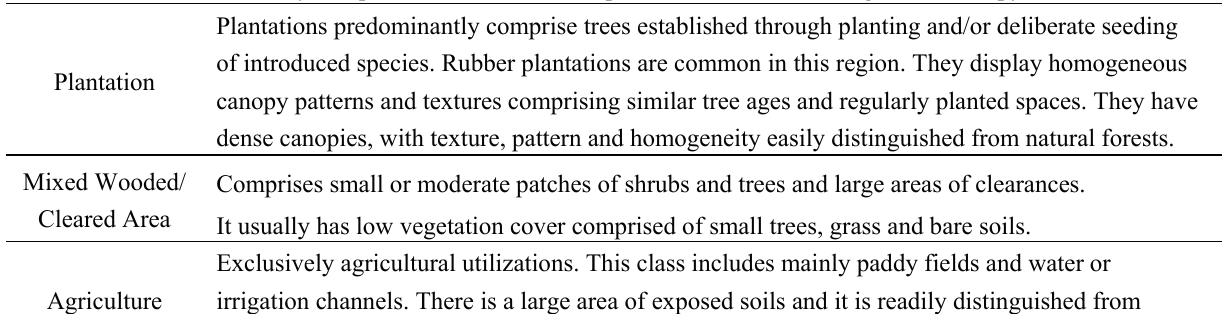
Table 1. Description of the four land cover types in the study area. Class Description Native Forest